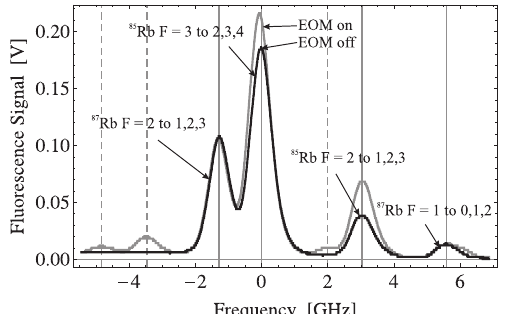
Figure 4. Fluorescence spectra from a pump laser beam passing through an EOM and a Rb vapor cell. The laser is scanned over several GHz and a fluorescence signal is recorded by photodiode C in Figure 3. The black curve shows the fluorescence with the EOM off. The grey curve is obtained with the EOM on. The operating frequency of the EOM is 2.915 GHz which represents the energy difference between the F = 3 → F (cid:48) = 4 and F = 2 → F (cid:48) = 3 transitions in 85